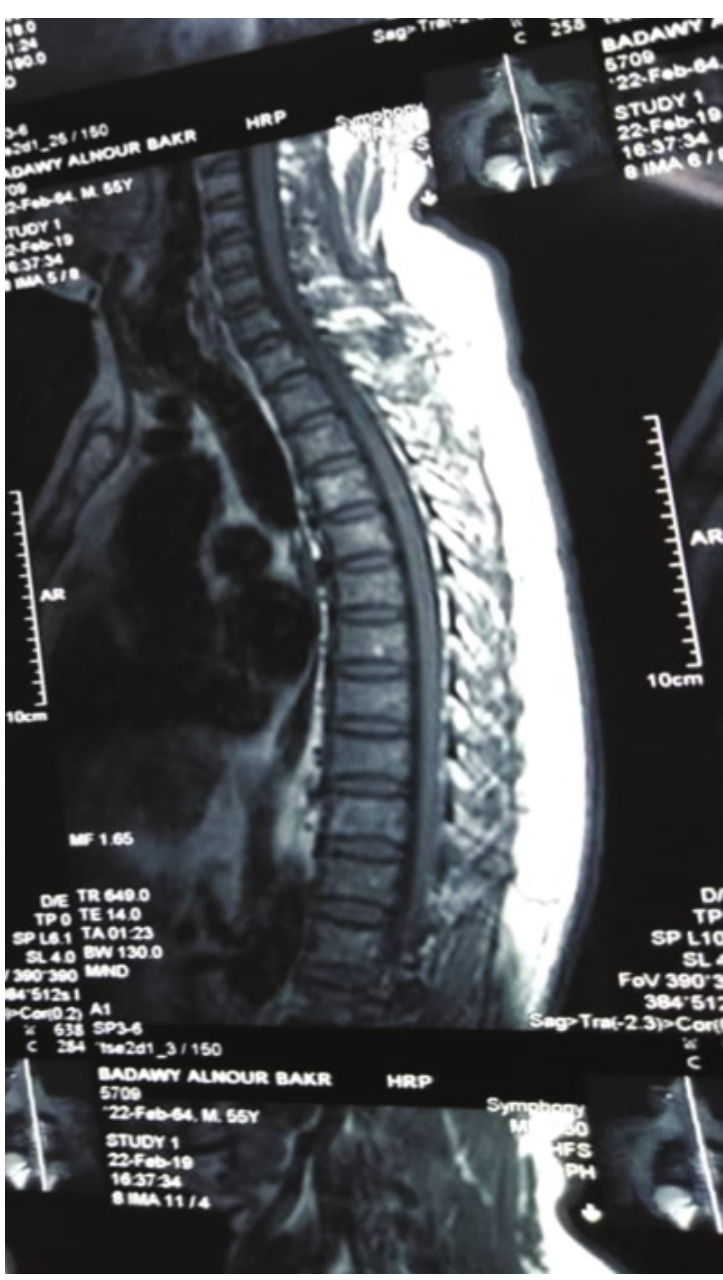
Figure 1: Cervical MRI and dorsal